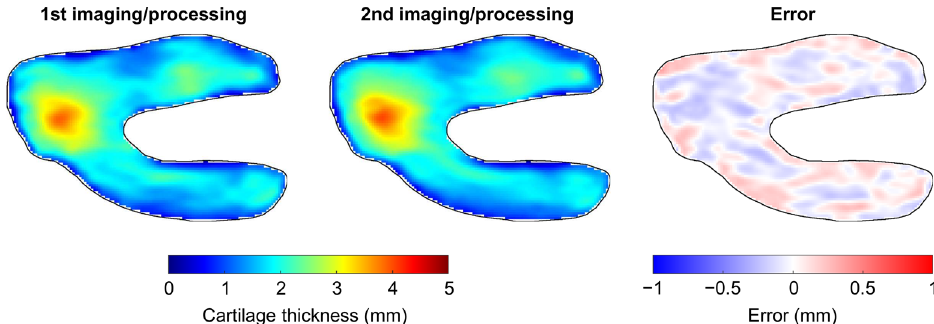
Figure 3. Illustration of the intra-operator reproducibility for a typical knee. This figure presents the anatomically standardized CTh map obtained with the first (left) and second (center) imaging/processing, as well as the error between the two maps (right).